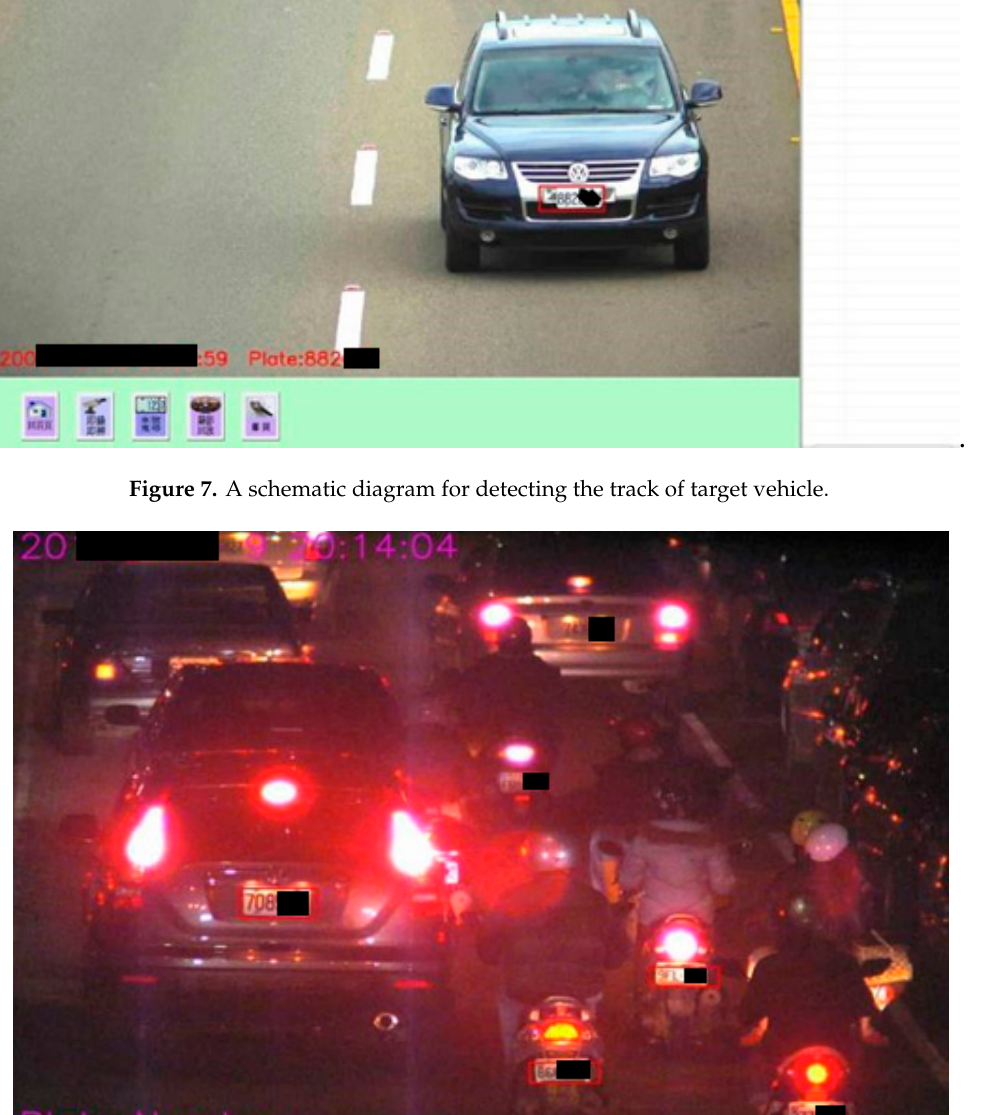
Figure 8. A schematic diagram for detecting the obstruction case.